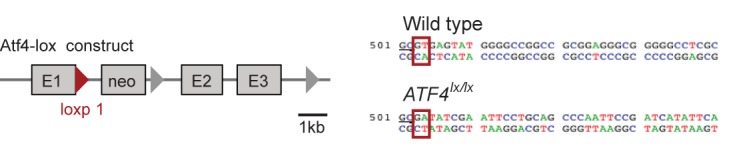
The structure of a targeted ATF4 allele (Yoshizawa et al., 2009), indicating the placement of a loxp-flanked neo cassette at the 3’ end of the exon 1 (E1).Red triangle represents the first loxp site. Sequences comparing the wildtype allele at the end of exon 1 and the loxp allele (underlined GC bases) show the disruption of the splice site (red boxes) at the beginning of the first intron upon insertion of the neo cassette.